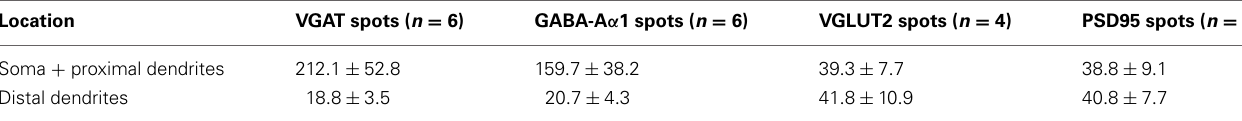
Table 1 | Quantification of GABAergic and glutamatergic synapse components in P0 motor neuron somas and distal dendrites. Location VGAT spots ( n = 6) GABA-A α 1 spots ( n = 6) VGLUT2 spots ( n = 4) PSD95 spots ( n = 4) Soma + proximal dendrites 212 . 1 ± 52 . 8 159 . 7 ± 38 . 2 39 . 3 ± 7 . 7 38 . 8 ± 9 . 1 Distal dendrites 18 . 8 ± 3 . 5 20 . 7 ± 4 . 3 41 . 8 ± 10 . 9 40 . 8 ± 7 . 7 Spots are quantified using the method described above, with VGAT and VGLUT2 pre-synaptic spots being within 1 μ m of a GABA-A α 1 receptor subunit or PSD-95 spot respectively. Data presented as mean ± SEM. Below, we quantify the number of spots of each type found in our sample at representative parts of the motor neuron ; there is a higher proportion of inhibitory synapses found on the soma and proximal dendrites (PDs), while there is a higher proportion of excitatory synapses found on the distal